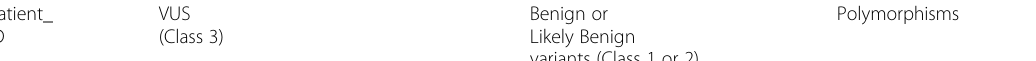
Table 2 Characterization of germline variants found among Norwegian familial CRC individuals